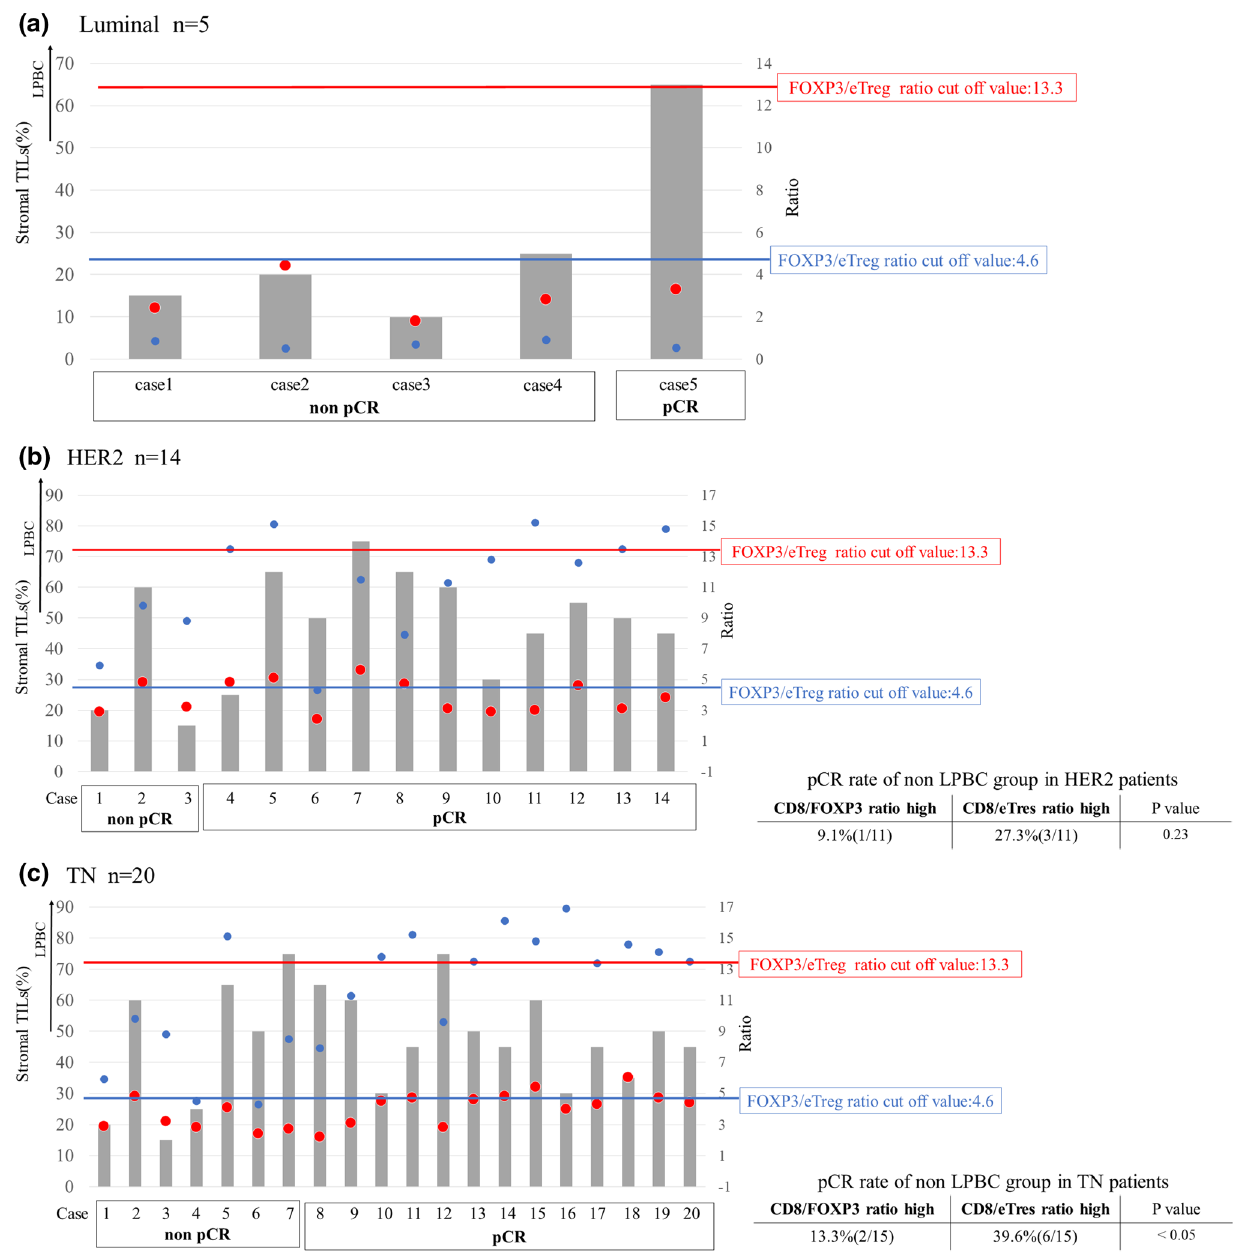
Fig. 2 Detailed data of patients who underwent NAC of a luminal, b HER2, and c TN subtypes. The stroma TIL, CD8/FOXP3 + ratio (blue dot, cut off value: 4.6), CD8/eTreg ratio (red dot, cut off value;13.3), and treatment response (pCR or non pCR) are shown in each case. pCR patho- logical compete response, TN triple